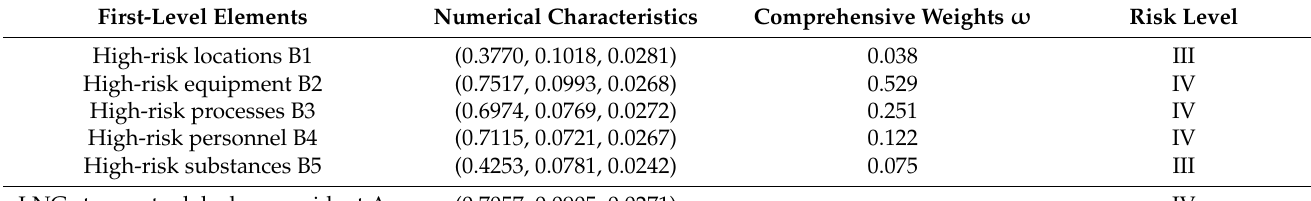
Table 9. Numerical characteristics of LNG tank leakage accident.